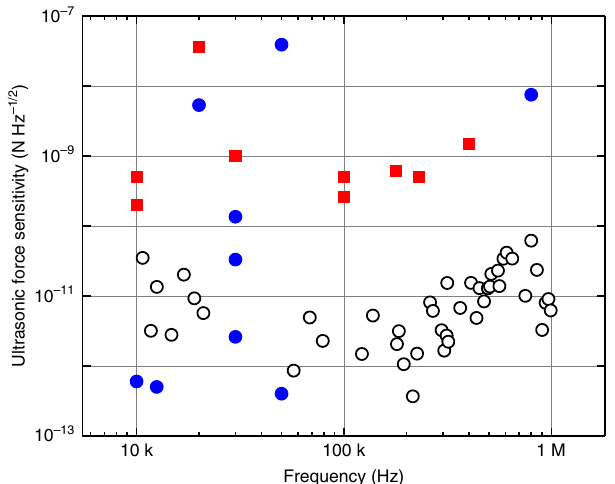
Fig. 5 Ultrasonic force sensitivity in comparison with other air-coupled sensors. Ultrasonic force sensitivity is evaluated as the noise equivalent pressure sensitivity multiplied by the sensing area and plotted versus frequency: open circles correspond to this work and solid symbols show results of other optical (blue circles) and electrical (red squares) approaches. The improvement of the sensitivity in this work is especially notable between 80 kHz and 1 MHz. Citations to previous work are provided in the Supplementary Fig.